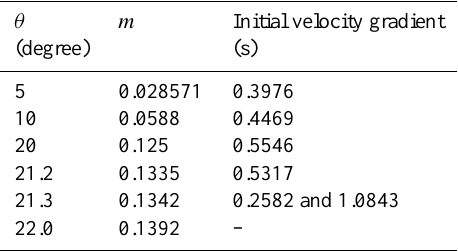
Table 1. The estimated initial guess for different wedge angles had been tabulated below. It can be observed that when the angle is 21.3 ◦ , the solution begins to oscillate between two values. As we increase the angle further, the method fails to converge to a